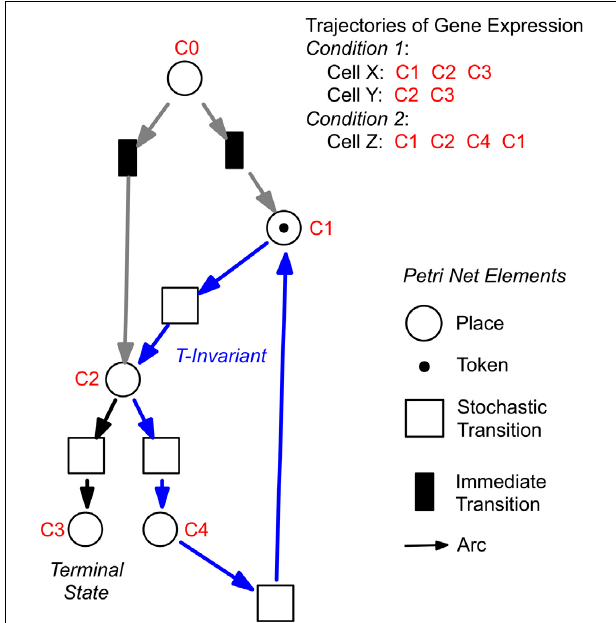
FIGURE 5 | Construction of Petri nets from single cell trajectories of gene expression. Petri nets are directed, bipartite graphs with two types of nodes, places and transitions, that are connected by arcs (see symbols, lower right). Petri nets are used in this work to model state machines, as exemplified in the following. Any gene expression state of a cell, as defined by its assignment to a Simprof significant cluster of gene expression patterns, is represented by a corresponding place (drawn as a circle). Any transit between two states is mediated by a transition (drawn as a rectangle). The current gene expression state of a cell is indicated by one token which marks the respective place. When a place contains a token, one of its post-transitions can fire to move the token into its post-place. (A post-transition of a place is a downstream transition which is immediately connected to that place, as indicated by a directed arc). Because each transition of the Petri nets as they are used here, has exactly one pre-place (one incoming arc) and one post-place (one outgoing arc), and because all arc weights are one, tokens can neither be produced nor destroyed, and the state of gene expression remains unequivocally defined. A transit cycle, i.e., the ensemble of reactions that bring a subsystem back to the state from which it started, is called transition-invariant (T-invariant) (Sackmann et al., 2006). The arcs that contribute to the T-invariant of the Petri net displayed in the figure are highlighted in blue. Petri nets, as they are used in this paper, contain one additional place C0, which does not represent a gene expression state. For simulation, C0 defines the initial gene expression state of the cell by randomly delivering its token to one of the places that are connected to C0 through so-called immediate transitions (filled in black) that fire immediately when the simulation starts [for details see (Rätzel et al., 2020)]. Connection to C0 also graphically highlights the places representing those gene expression states in which cell trajectories started. In the example shown, the cell trajectory started in a gene expression state assigned to Simprof cluster C1. The token can move to C2 where it randomly moves to either C3 (a terminal state in this example) or to C4, from which it may return to C1 and possibly